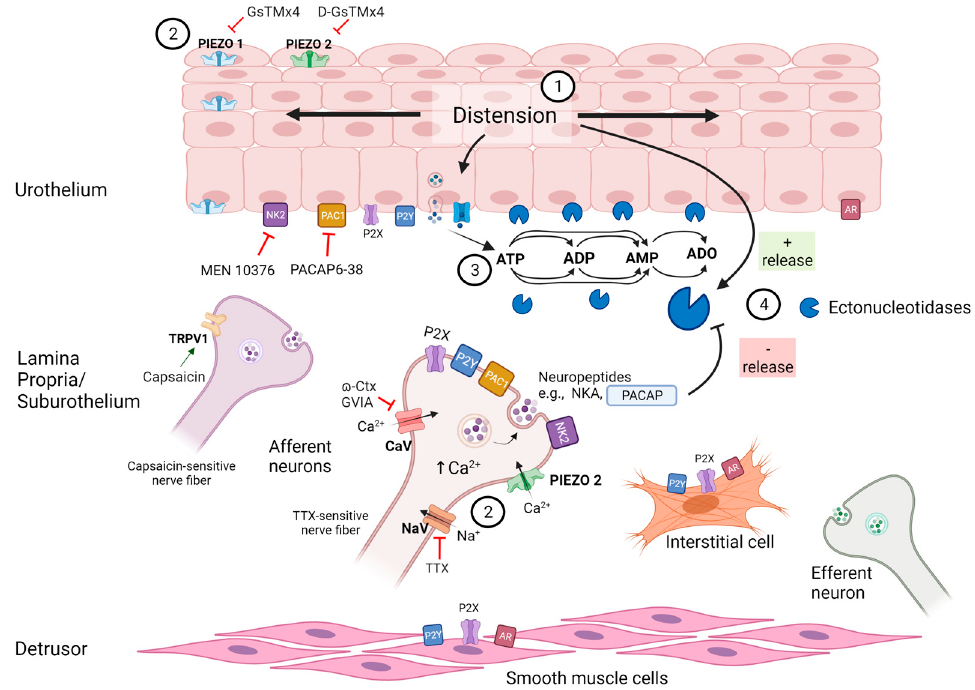
Figure 10. A model depicting mechanosensitive regulation of s-ENTD release in the bladder lamina propria. Distention of the bladder wall during bladder filling ( 1 ) causes activation of PIEZO channels [19,20] and mechanosensitive afferent neurons [15–17] ( 2 ) as well as release of ATP [1,14,17] and of soluble ectonucleotidases (s-ENTDs) [9] from the urothelium into the lamina propria. ATP is then degraded to ADP, AMP and adenosine (ADO) by membrane-bound and s-ENTDs [8,9] ( 3 ). ATP, ADP and ADO activate P2X, P2Y and adenosine (AR) receptors in various cell types in the LP and detrusor muscle. Simultaneously, activation of PIEZO channels, TTX-sensitive neurons and PAC1 receptors in response to distention restrain the additional release of s-ENTDs ( 4 ) to avert the excessive degradation of ATP and preserve bioactive purines at effective concentrations at receptor sites. Controlled inhibition of s-ENTD release is likely mediated by substances (e.g., PACAP and other neuropeptides) that are released from sensory neurons and/or urothelium in response to distention during bladder filling. The release of s-ENTDs and consequent extracellular ATP metabolism in the lamina propria is under complex regulation (Figure created with